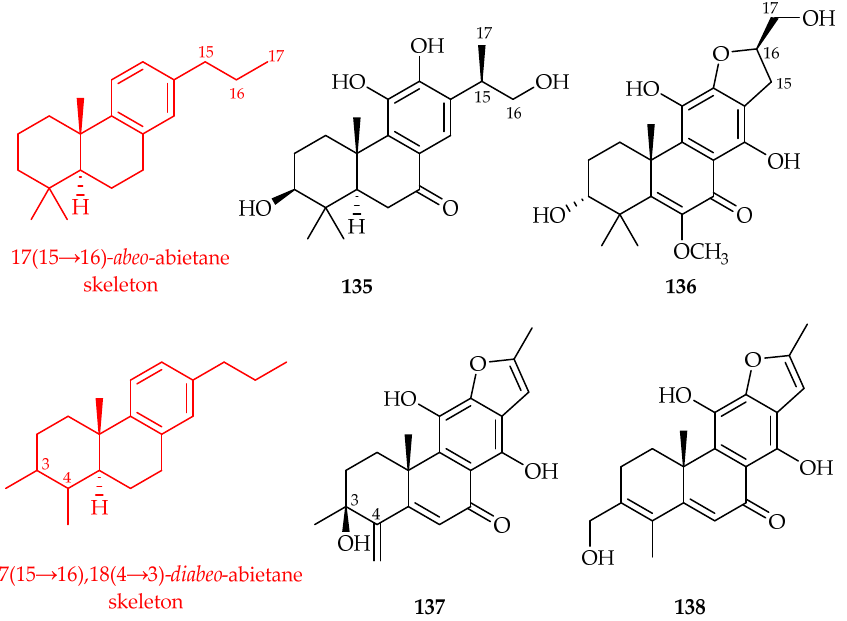
Figure 56. Structures of clerodenoid A 135 , clerodenoid D 136 , clerodenoid E 137 , and clerodenoid F 138 [85].